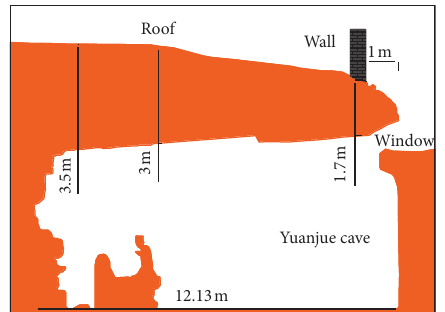
Figure 3: Structure characteristics of A-A